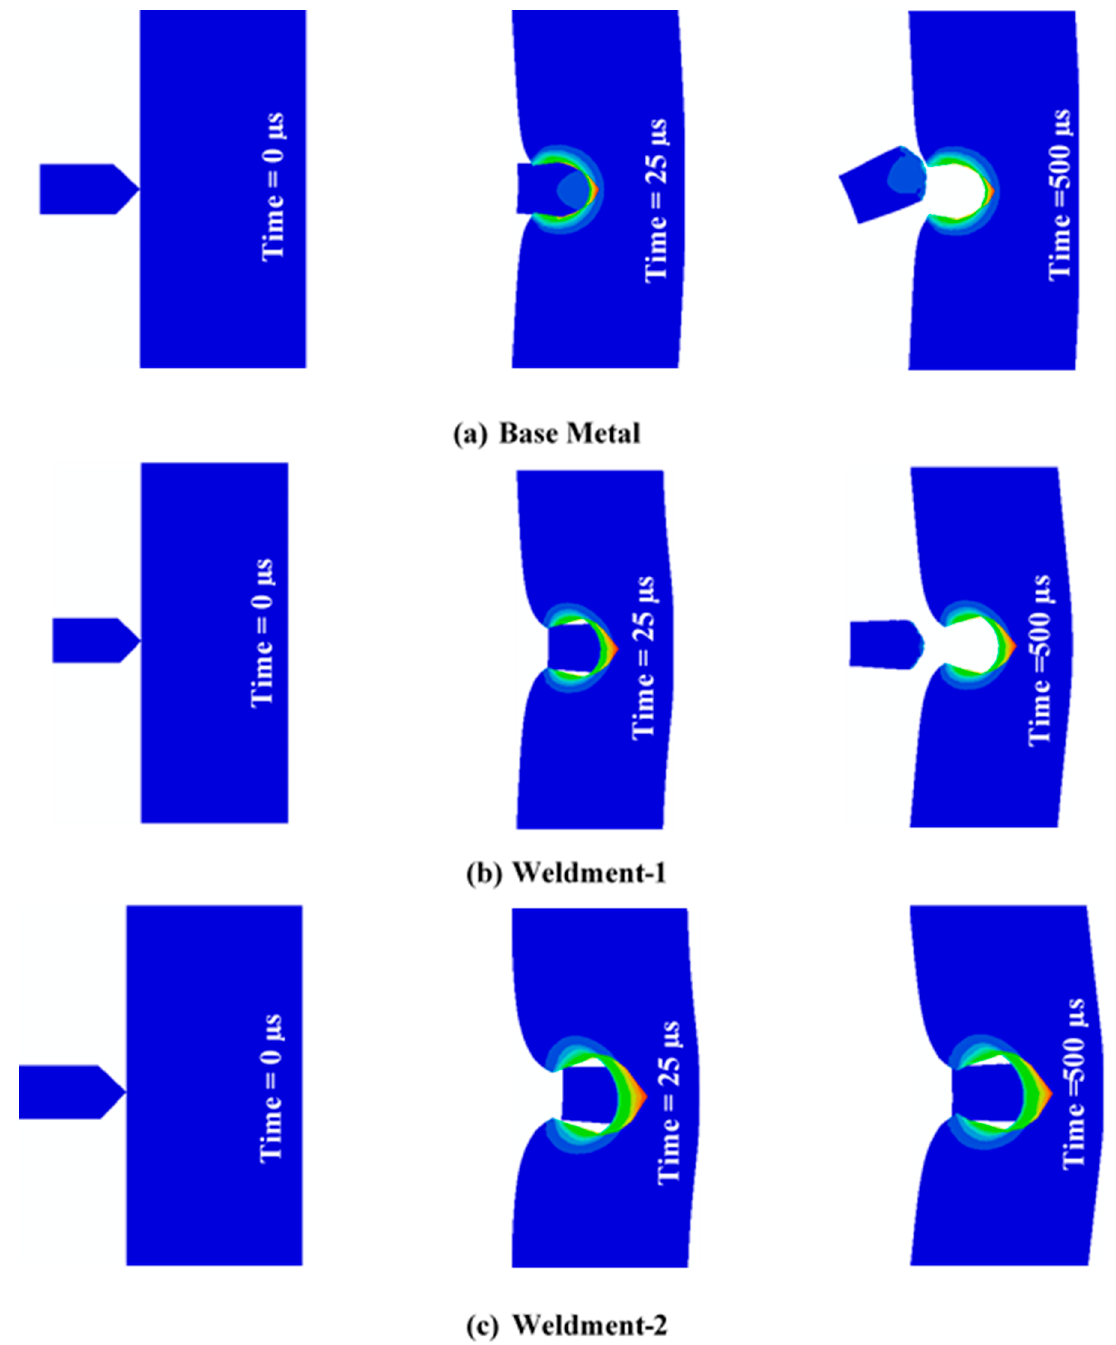
Figure 9. Depth of Penetration contours at different step time for ( a ) Base Metal, ( b ) Weldment-1, ( c ) Weldment-2.